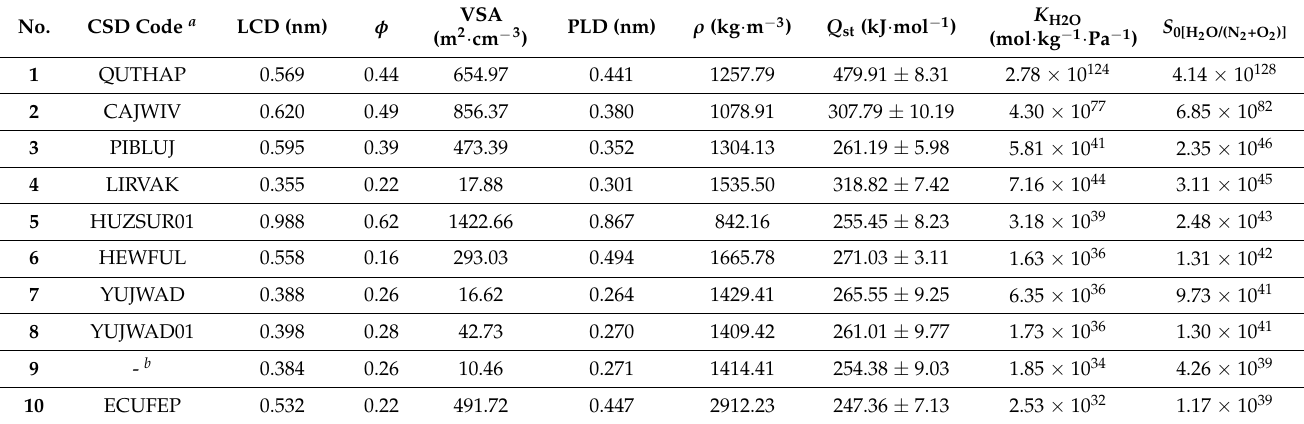
Table 1. Top 10 CoRE-MOFs with optimal performance of water